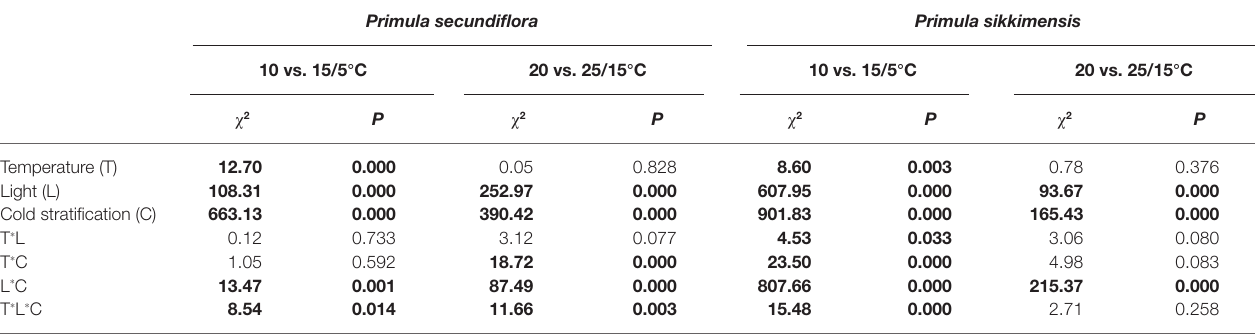
TABLE 2 | GLM results for the effect on seed germination of alternating and corresponding constant temperatures (15/5 vs. 10 and 25/15 vs. 20 ° C) in relation to the following factors: temperature, light, and cold